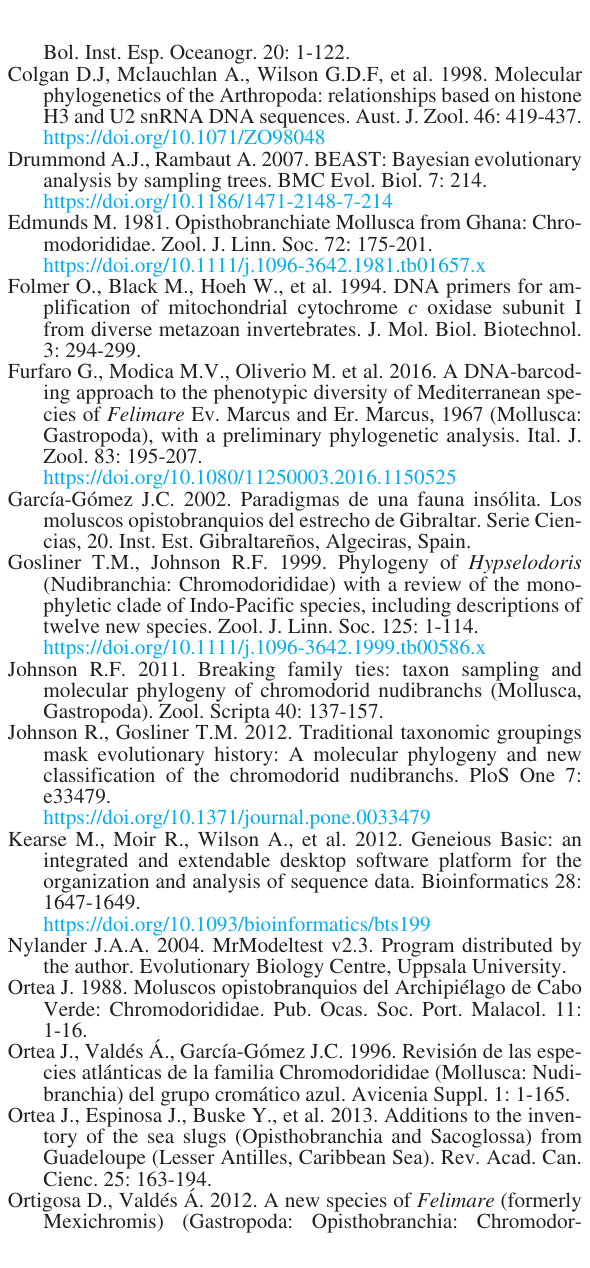
Fig. S1. – Phylogenetic hypothesis based on BI for each gene (16S, COI, H3). Numbers above branches represent PP. Numbers be- low branches represent BS. Unsupported branches not labelled. The new species is within the grey